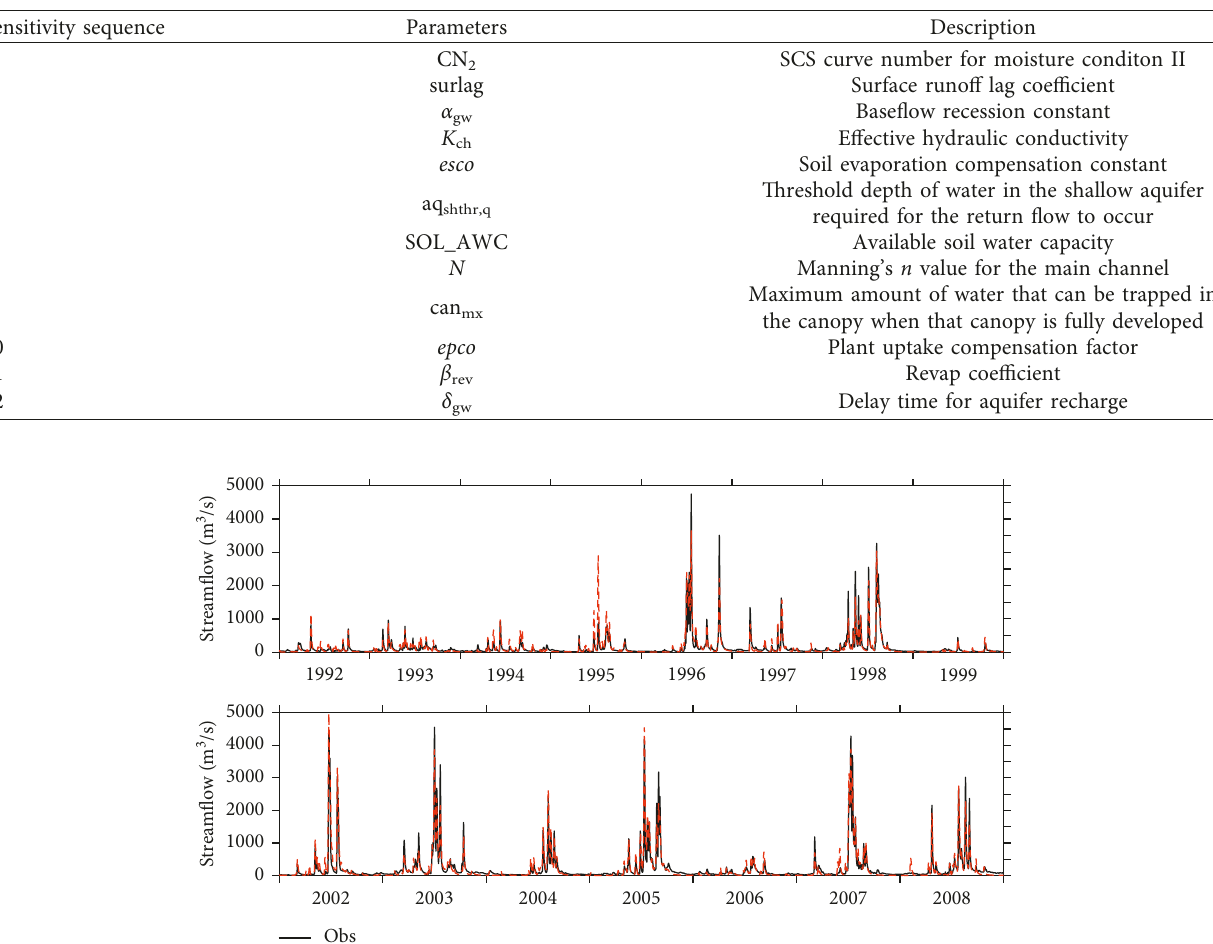
Table 2: SWAT model parameters being calibrated.